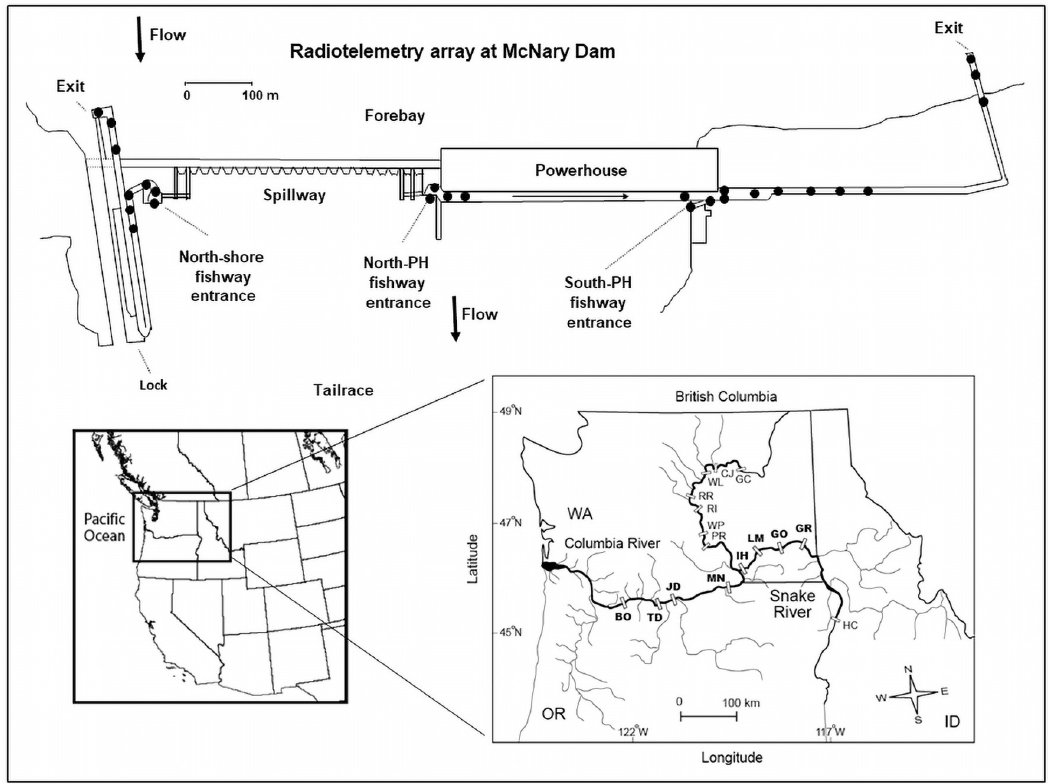
Fig 1. Diagram showing a typical radiotelemetry-monitoring array used in annual adult salmon and steelhead studies. The example shows McNary Dam (MN) on the lower Columbia River and includes the primary adult fishway entrances and sites ( ● ) where single or multiple underwater coaxial cable antennas were used to monitor fish movements; aerial antennas located downstream to monitor the dam tailrace are not shown. Insets show the western United States and Canada (left) and the locations of dams in the lower Columbia and Snake Rivers (right). Bold text indicates study dams: BO (Bonneville), TD (The Dalles), JD (John Day), MN (McNary), IH (Ice Harbor), LM (Lower Monumental), GO (Little Goose), and GR (Lower Granite). Dams that were not a part of this summary, but are mentioned in the text include: PR (Priest Rapids), WP (Wanapum), RI (Rock Island), RR (Rocky Reach), WL (Wells), CJ (Chief Joseph), GC (Grand Coulee), and HC (Hells Canyon); there is currently no upstream fish passage at Chief Joseph or Hells Canyon dams. The McNary Dam image is similar but not identical to line drawings by the U.S. Army Corps of Engineers and is for illustrative purposes only.